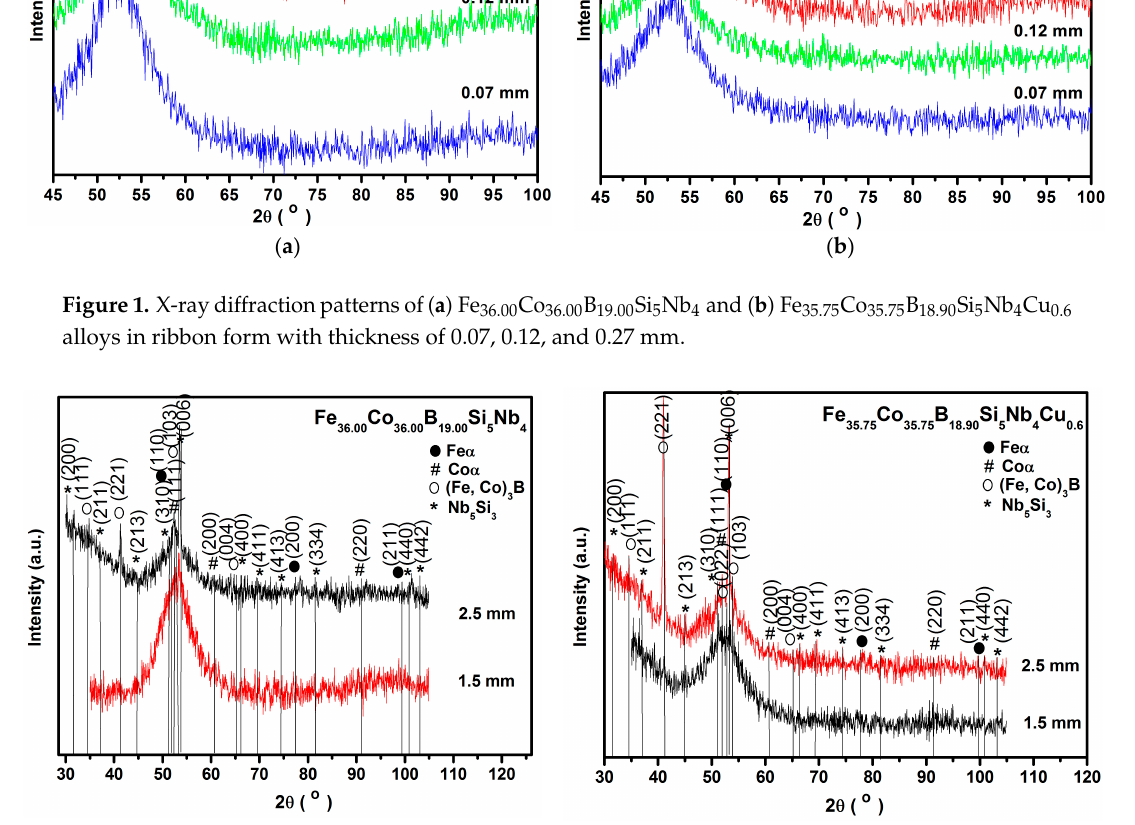
Figure 3. High-resolution transmission electron microscopy (HRTEM) images and the selected area electron diffractions (SAED) of ( a ) Fe 36.00 Co 36.00 B 19.00 Si 5 Nb 4 and ( b ) Fe 35.75 Co 35.75 B 18.90 Si 5 Nb 4 Cu 0.6 amorphous alloys in ribbon form with the thickness of 0.07 mm. The obtained results of structural studies of ribbons and the rod with the diameter of 1.5 mm performed by the HRTEM micrograph are presented in Figures 3 and 4. An example of the HRTEM images of the ribbon samples with the thicknesses of 0.07, 0.12, and 0.27 mm is shown in Figure 3a. Figure 4a presents the HRTEM image of the rod with the diameter of 1.5 mm. The selected area electron diffractions (SAED) taken from these samples are shown in Figures 3b and 4b. In the images (Figures 3a and 4a), we can observe the positions with randomly distributed dark and bright contrasts. From the HRTEM images we may conclude that local short-range order (SRO) regions have occurred during the cooling of the Fe-Co-based metallic glass. The selected area electron diffraction (SAED) pattern consisted only of halo rings (Figures 3b and 4b). The diffuse diffraction halos may be taken as characteristic of the amorphous state. However, this characteristic alone is not sufficient to